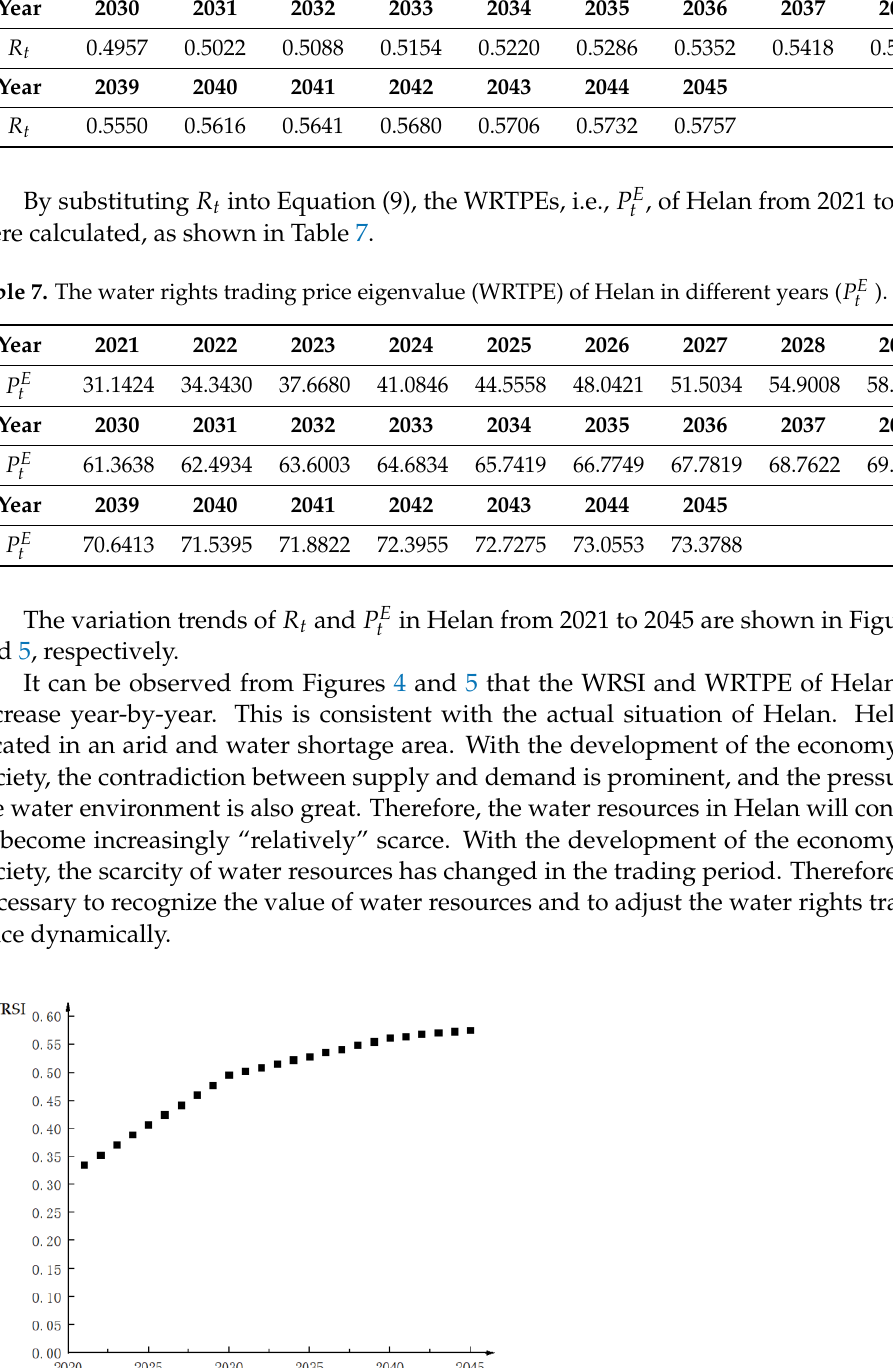
Table 6. The water resource scarcity index (WRSI) of Helan in different years ( R t ).